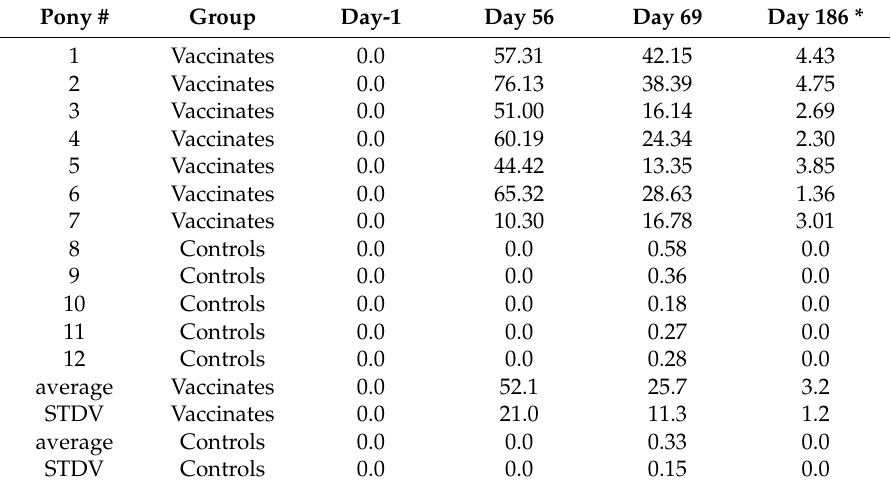
* Day 186: day of infection by individual